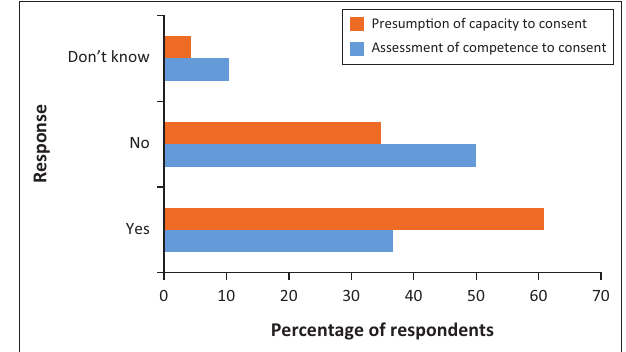
FIGURE 1: Time spent on information disclosure.